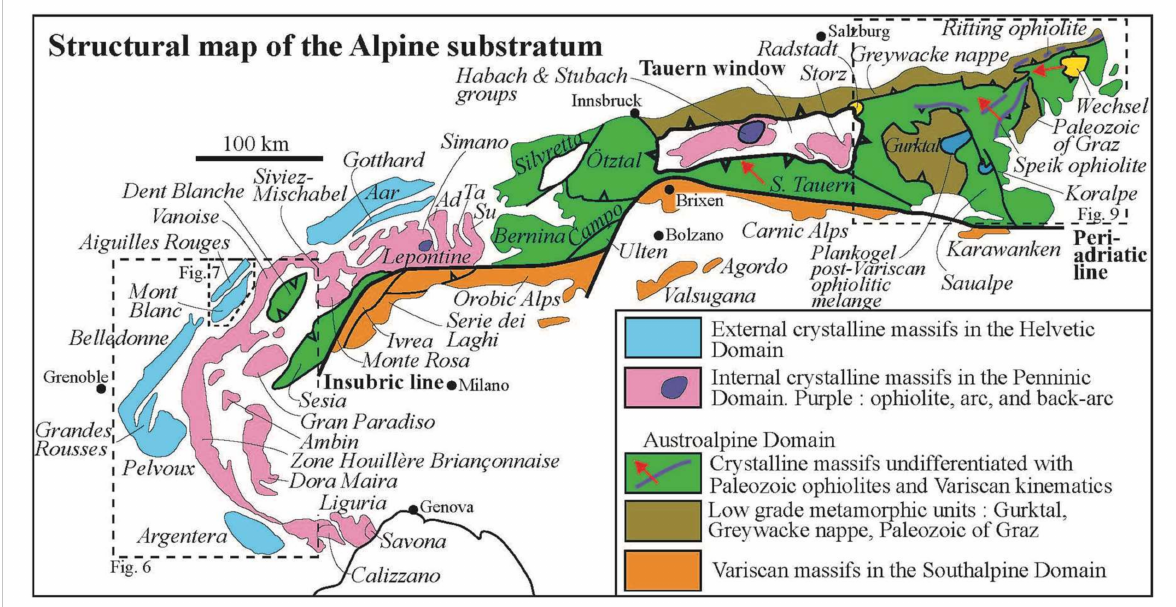
Figure 5. Tectonic map of the Alpine substratum showing the Paleozoic rocks involved in the Helvetic, Penninic, Austroalpine, and South Alpine domains. Ad: Adula, Ta: Tambo, Su: Suretta. Note that the term “substratum” includes both the pre-Middle Carboniferous basement already deformed during the Variscan orogeny, and the Late Carboniferous or Permian sedimentary formations and magmatic rocks that experienced only the Alpine